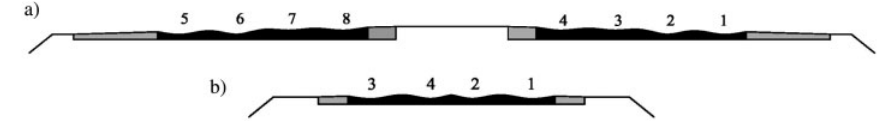
Fig. 1. The distribution of eight ruts (a) and four ruts (b) of a transverse track